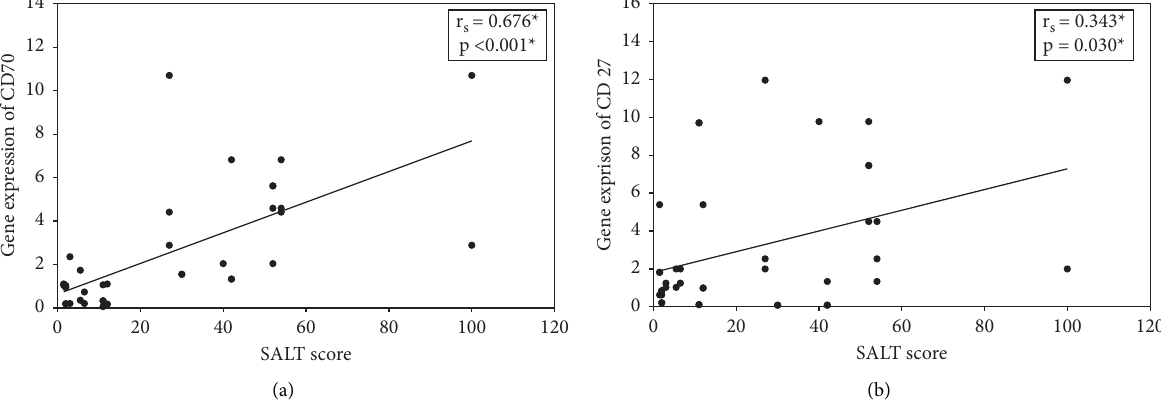
Figure 3: (a) The correlation between CD70 mRNA levels in AA lesions ( n � 40) and SALTscore. (b) The correlation between CD27 mRNA levels in AA lesions ( n � 40) and SALT score. rs: Spearman coefficient; ∗ significant at p < 0 . 05; AA: alopecia areata; SALT :Severity of Alopecia Tool; CD: cluster